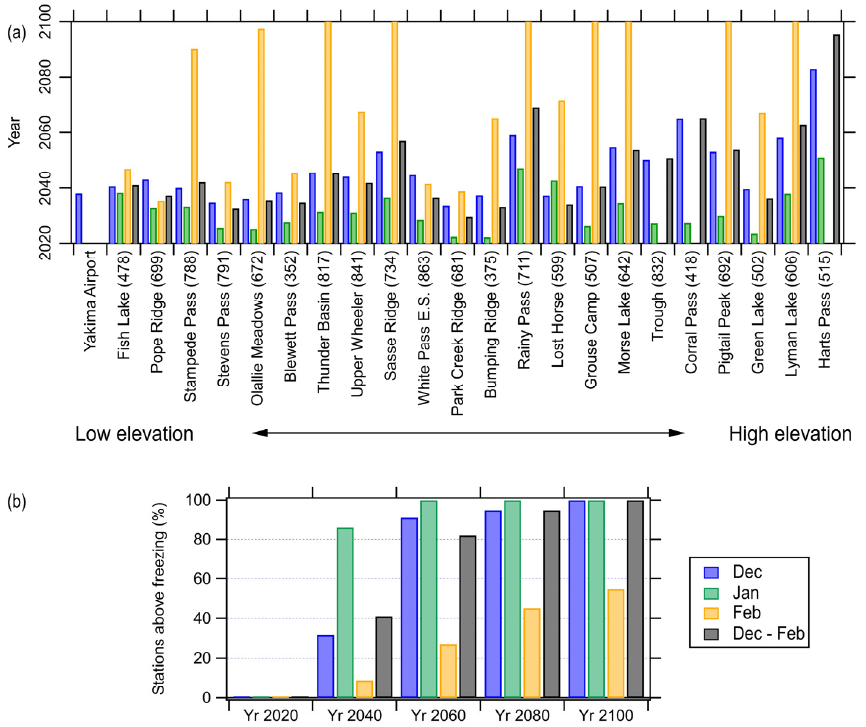
Figure 2. ( a ) Projected years when mean air temperatures will be above freezing for Yakima Airport and the 22 SNOTEL stations. Note that the current mean air temperature at the Yakima Airport was above freezing in 2020 for all months but December. Furthermore, there is no projection for the mean air temperature trends at Trough, Corral Pass, and Harts Pass during February because of a decreasing air temperature trend. Lowest to highest elevation stations are listed from left to right. ( b ) Projection of stations above freezing for winter months starting December through February and average for December through February.